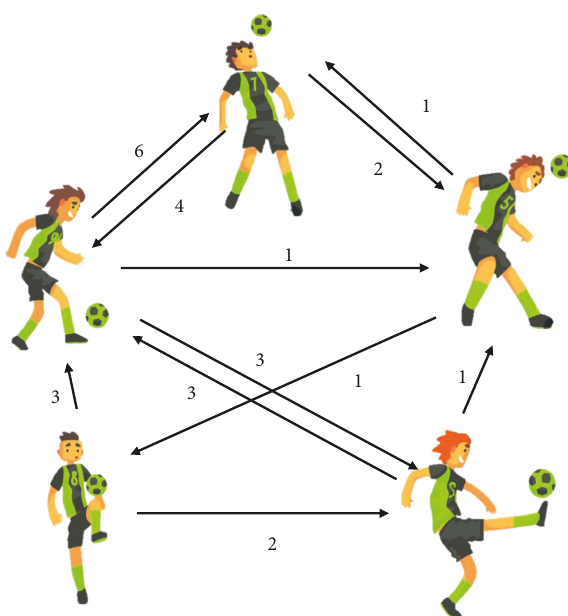
Figure 2: A small example for passing